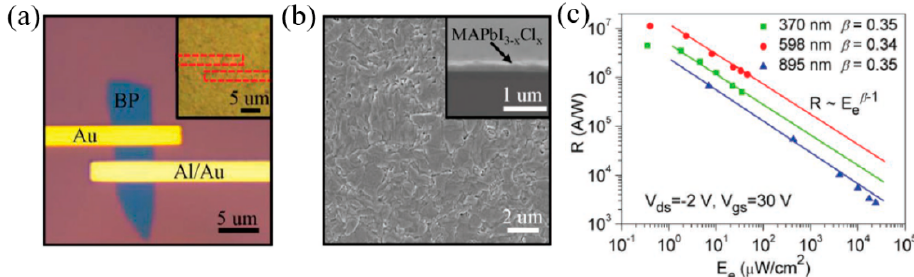
Figure 24. ( a ) Image of a BP/MAPbI 3 − X Cl X Schottky FET. The inset figure exhibits decorated with MAPbI 3 − X Cl X perovskite. ( b ) A typical plane view SEM image of the MAPbI 3 − X Cl X perovskite on silicon substrate. The inset figure shows the corresponding cross-sectional SEM image. ( c ) The response rate increases with the decrease in light intensity [313]. Copyright 2019 Wiley-VCH Verlag.